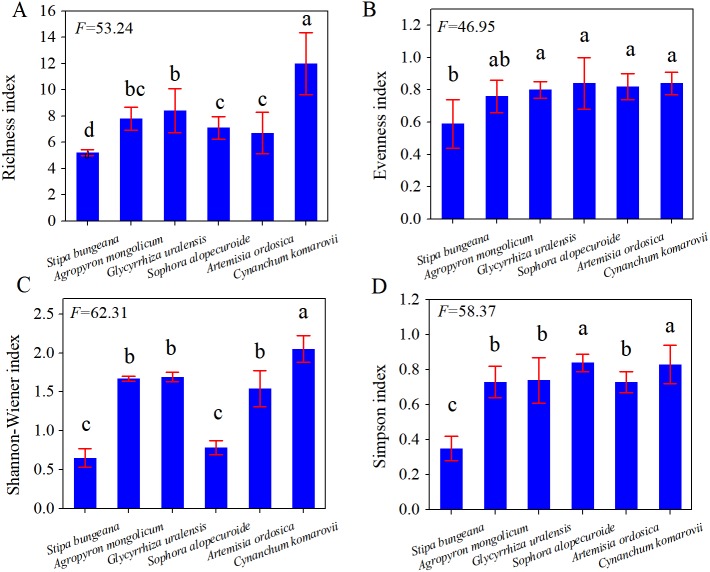
Diversity indices of different plant communities in desertified steppe.Comparison of the richness index (A), evenness index (B), Shannon–Wiener index (C) and Simpson’s index (D) for plant communities. Results of each split-plot two-way ANOVA are shown below each corresponding panel. Bars within a panel that share letters have means that differ significantly based on Tukey’s test. Error bars represent standard error. n = 15 here and subsequently.